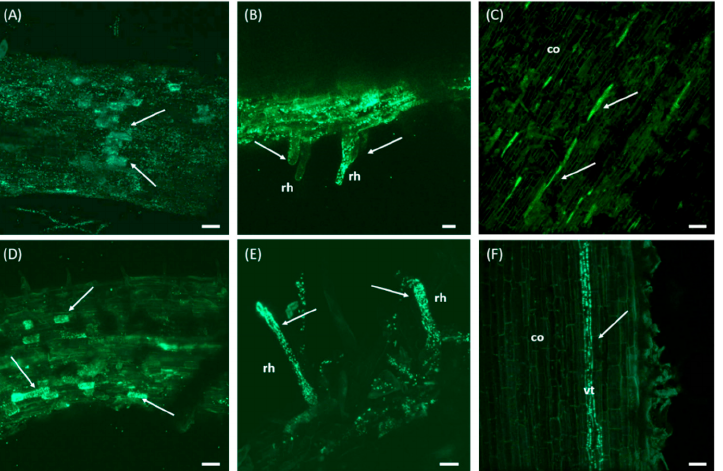
Figure 7. Confocal laser scanning microscopy images showing GFP ‐ labeled Pseudomonas sp. PICF6 ( A – C ) and Pseudomonas simiae PICF7 (D to F) cells colonizing olive roots (cv. Picual). Panels ( A ) and ( D ) show colonization of the root surface and inner colonization of epidermal cells. Panels ( B ) and ( E ) show inner colonization of root hairs. Panels ( C , F ) show internal colonization of root tissues. White arrows point to spots colonized by fluorescent bacterial cells. rh, root hair; co, cortex; vt, vascular tissue. Scale bars represent 50 μ m in ( A , C , D , F ), and 20 μ m ( B , E ).